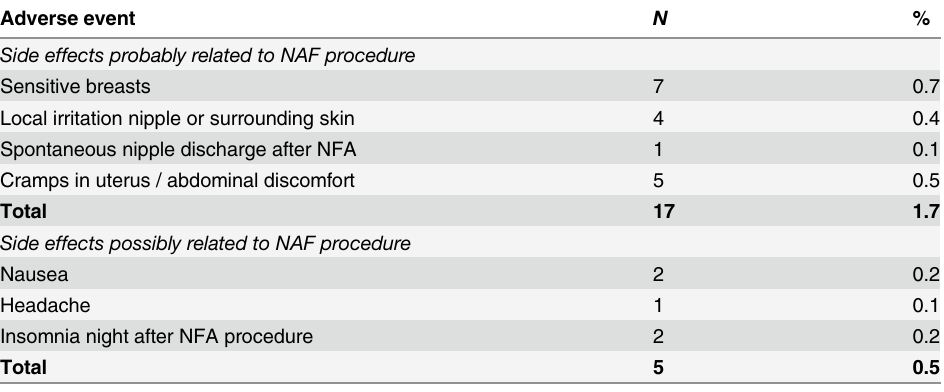
Table 3. Adverse events reported during and after 994 NFA procedures.